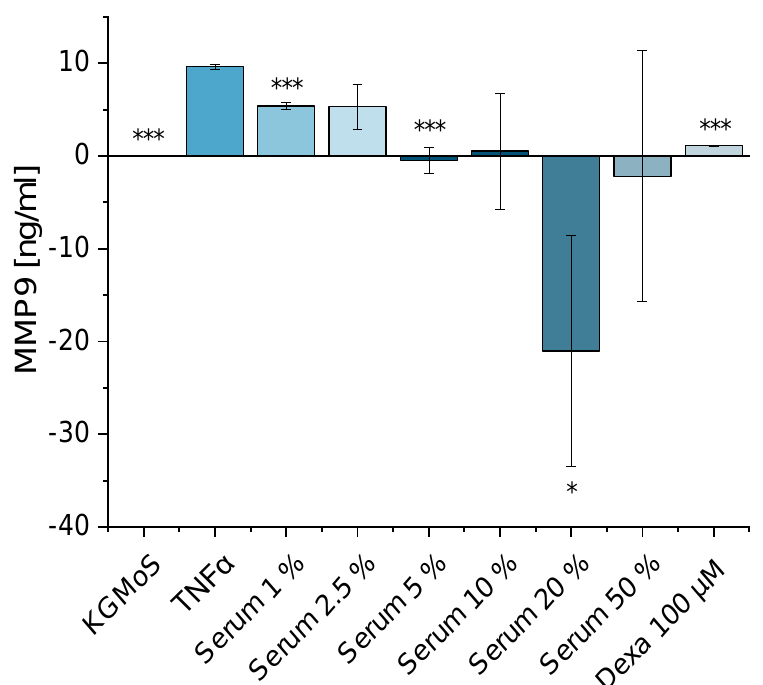
Figure 11. Protein expression of MMP9 in HCE-T cells; 24 h of cultivation with TNF α (10 ng/mL) in KGMwo.s. medium with different serum concentrations: 1%, 2.5%, 5%, 10%, 20%, 50%; 100 µ M dexamethasone served as a positive control, KGMwo.s. medium as a negative control; 3 wells per sample were analyzed (n well = 3); 2 technical replicates were conducted per well (n technical replicate = 2); mean ± SD, one-way ANOVA with * p ≤ 0.05 and *** p ≤ 0.001 .